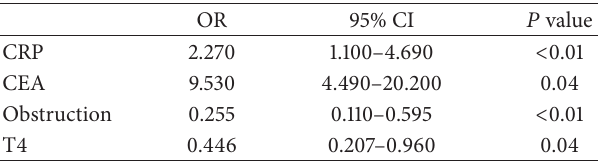
Table 3: Logistic multivariate analysis for the associations with interleukin-6 for all patients ( 𝑛 = 233 ).